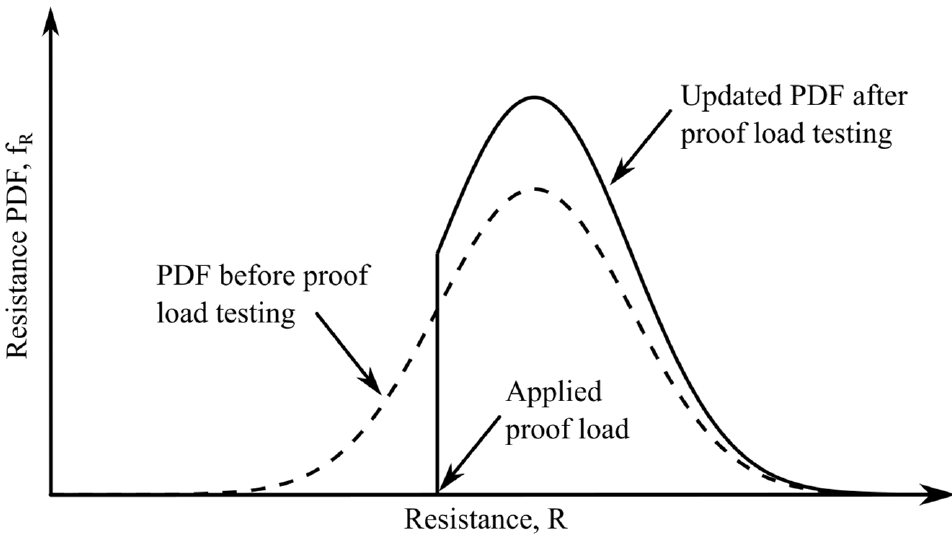
Figure 1. Probability density function (PDF) before and after proof loading.